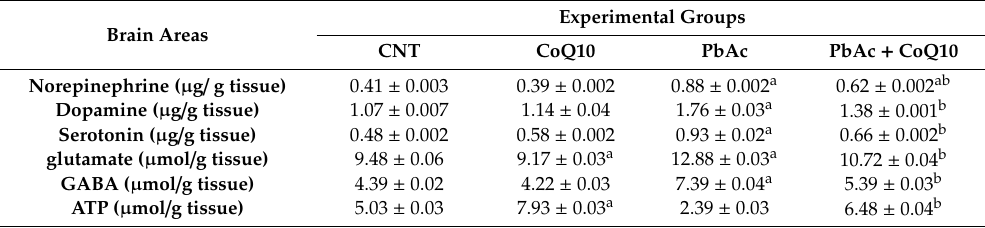
Table 2. Effect of coenzyme Q10 on cortical norepinephrine, dopamine, serotonin, glutamate, GABA and ATP content following lead acetate exposure.